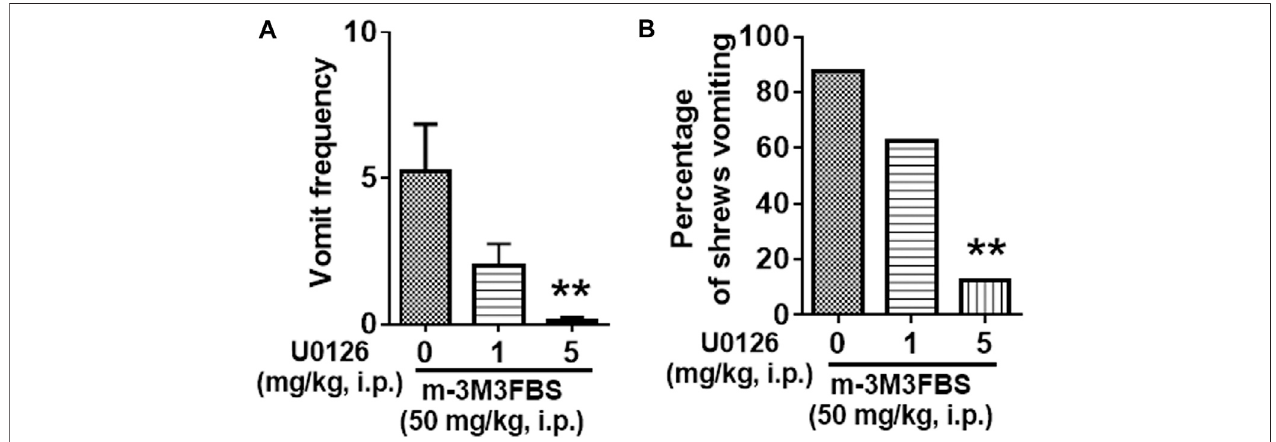
FIGURE 4 | Antiemetic effects of the ERK1/2 inhibitor U0126 against m-3M3FBS-induced emesis. Different groups of shrews were given vehicle or varying doses ofU0126(i.p.)( n (cid:1) 8shrewspergroup)30 minpriortom-3M3FBS(1 mg/kg,i.p.)administration.Emeticparameterswererecordedforthenext2 h. (A) Thefrequencyof emesis was analyzed with Kruskal-Wallis non-parametric one-way ANOVA followed by Dunnett ’ s post hoc test and presented as mean ± SEM. (B) Percentage of shrews vomiting was analyzed with chi-square test and presented as mean. *** p < 0.001 vs. 0 mg/kg.